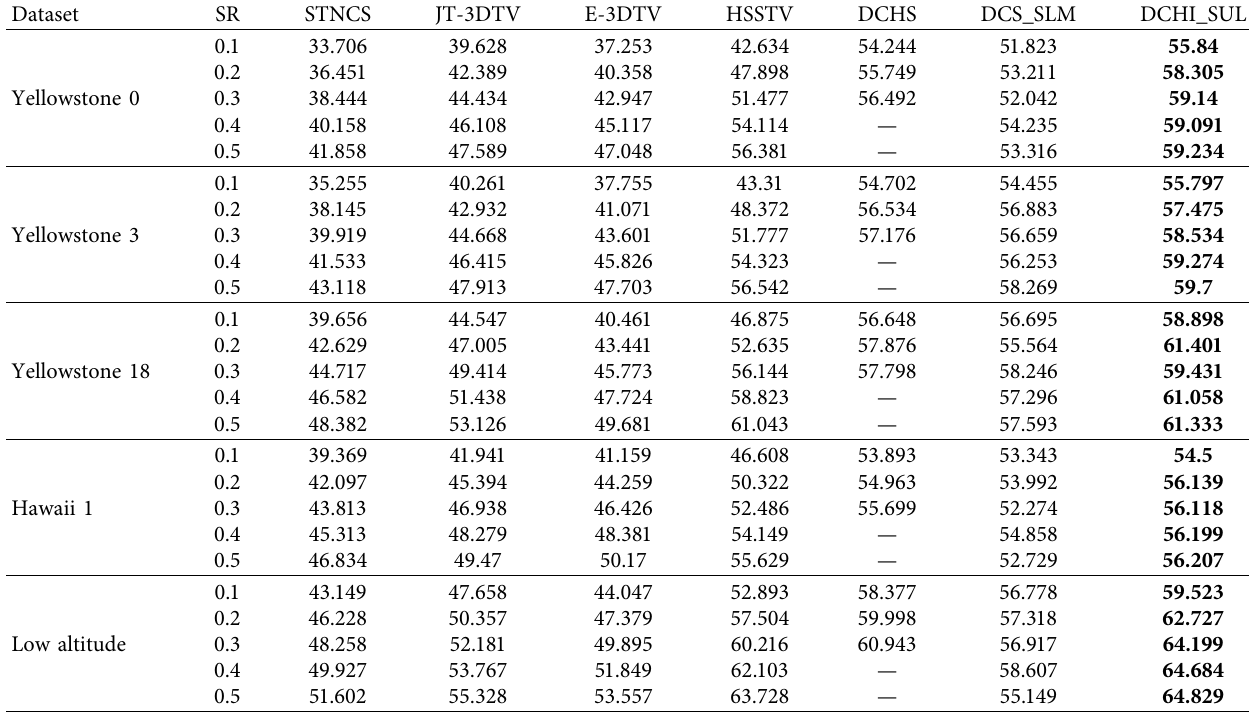
Table 1: MPSNR (dB) comparison of all competing methods under different sampling rates on five datasets. Dataset